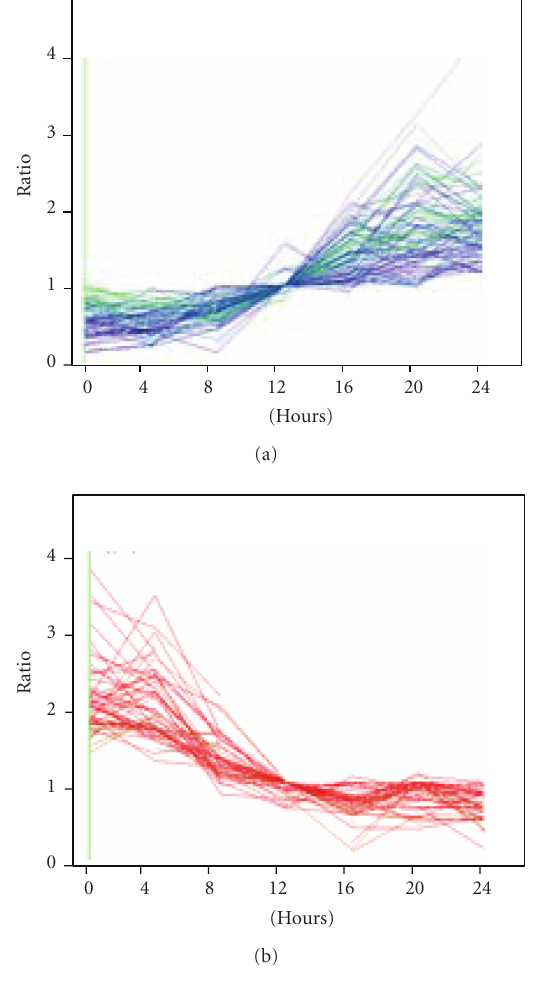
Figure 5: The upregulated and downregulated gene profiles of HB- MEC during C. neoformans infection. (a) Upregulated genes (left chart): cytochrome P450 gene was continuously upregulated dur- ing the course of infection. Genes that have correlation at least 0.95 to the expression profile of cytochrome P450 are grouped and de- fined as upregulated genes. (b) Downregulated genes (right chart): TNNI3 gene was continuously downregulated during the course of infection. Genes that have correlation at least 0.95 to the expression profile of TNNI3 are grouped and defined as downregulated genes.